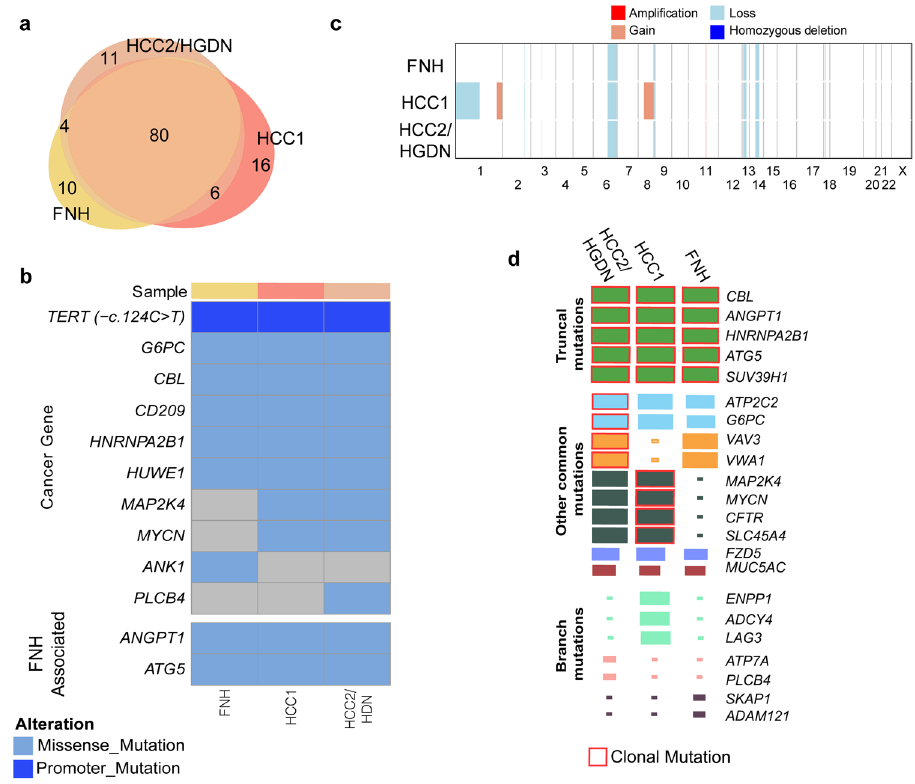
Fig. 3 Genetic characterization of Focal Nodular Hyperplasia (FNH) and two associated Hepatocellular Carcinoma (HCC) components. a Venn diagram representing the number of somatic mutations detected in each lesion subjected to whole-exome sequencing (WES) ( b ) Oncoprint of genetic alterations detected in FNH, and associated HCC components by WES. Alterations are colored according to the legend. Alterations shown are those included in cancer gene lists (see Supplementary Data 1). c Summary of genome-wide copy number alterations detected by WES. Copy number changes are colored according to the legend. d Chart showing clonality of selected mutations in each cluster. Size of square denotes cancer cell fraction of